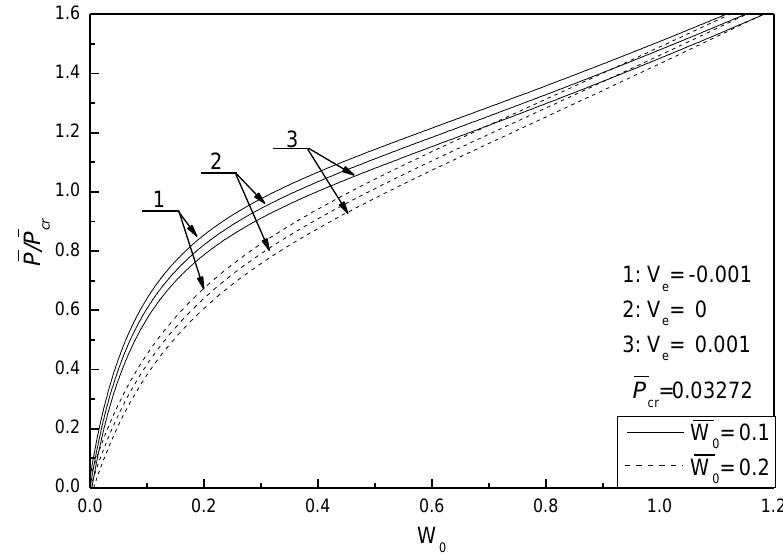
Figure 6. Effect of electrical loads on postbuckling response curves of piezoelectric plate without damage under two different initial